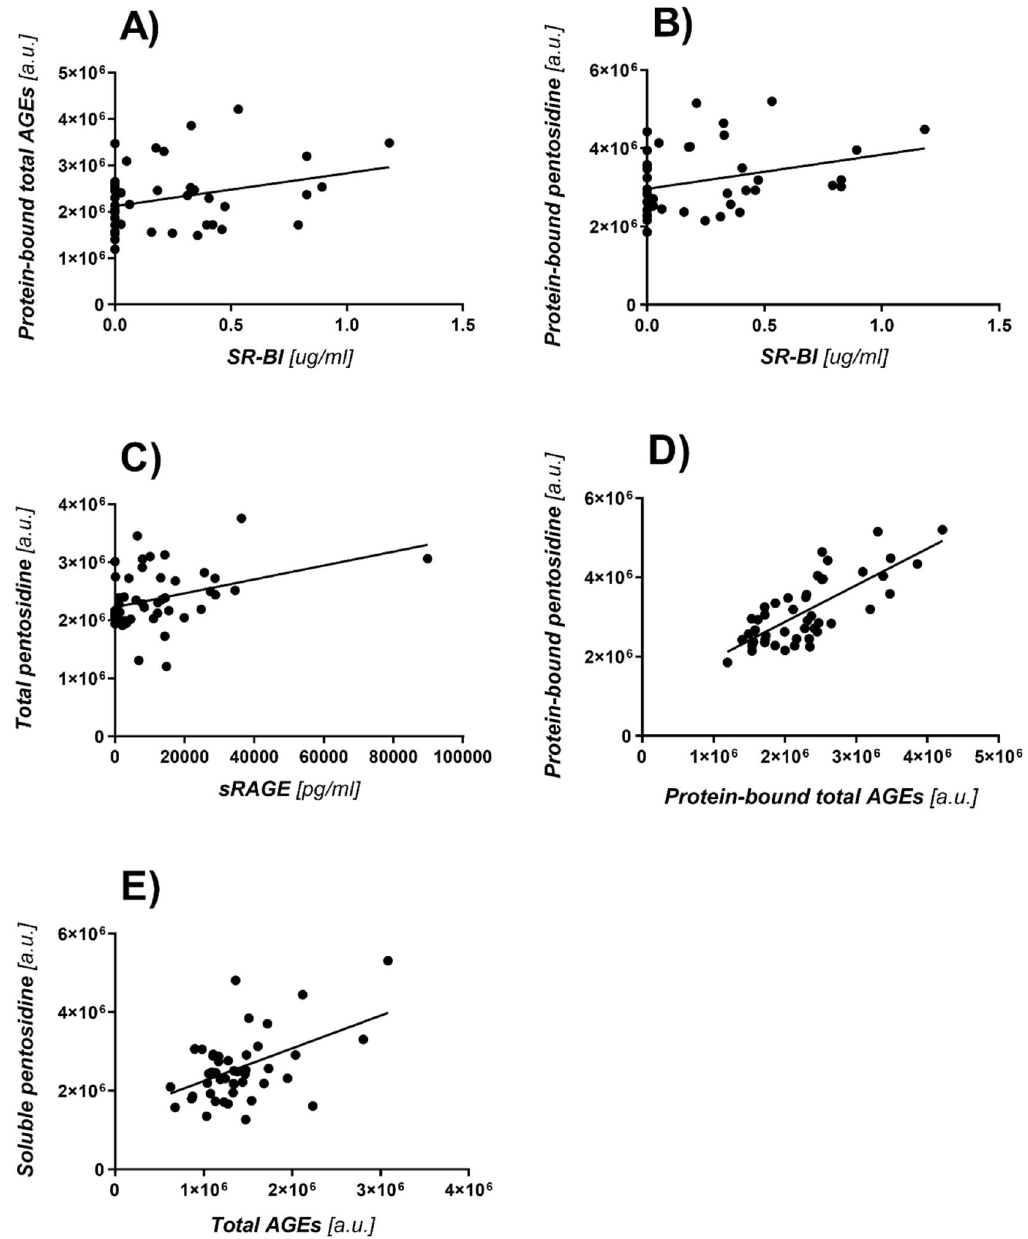
Figure 1. ( A ) Graph of the correlation between the concentration of SRBI receptors and total AGEs bound to proteins, ( p = 0.0493, r = 0.3052). ( B ) Graph of the correlation between SR-BI and pentosidine bound to proteins, ( p = 0.0481, r = 0.3068). ( C ) Graph of the correlation between sRAGE and pentosidine measured in the whole sample, ( p = 0.0094, r = 0.3675). ( D ) Graph of correlation between protein-bound total AGEs and protein-bound pentosidine, ( p < 0.0001, r = 0.761). ( E ) Graph of the correlation of AGEs measured in the whole sample and soluble pentosidine, ( p = 0.0006, r =